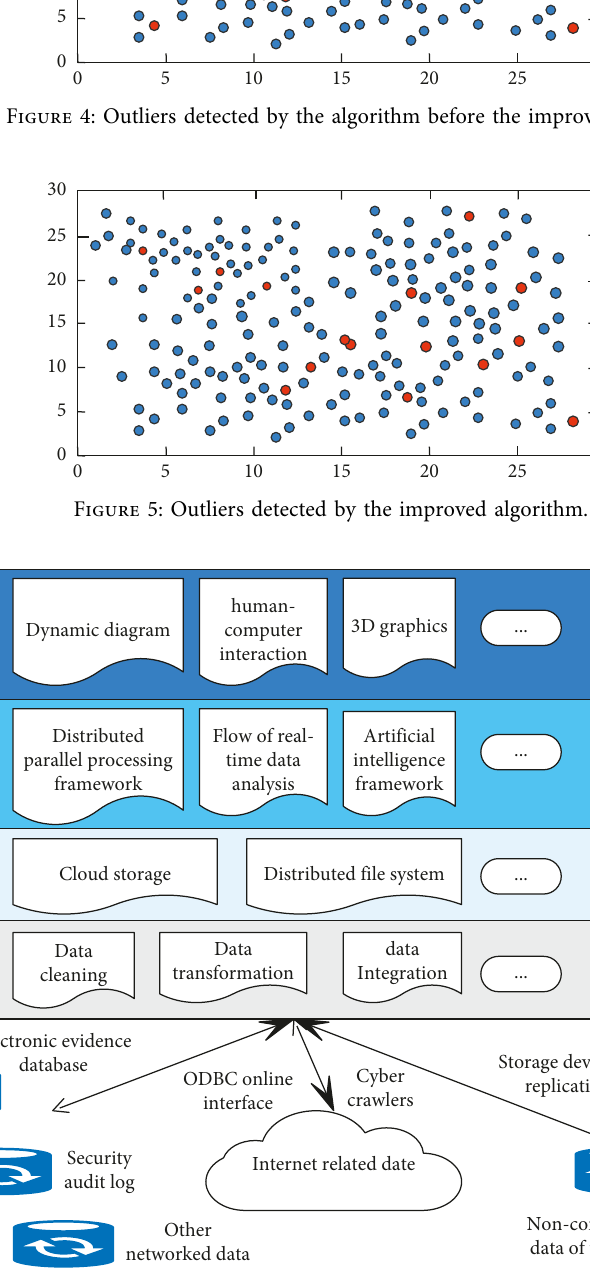
Figure 6: Overall block diagram of big data audit technology based on improved association algorithm.